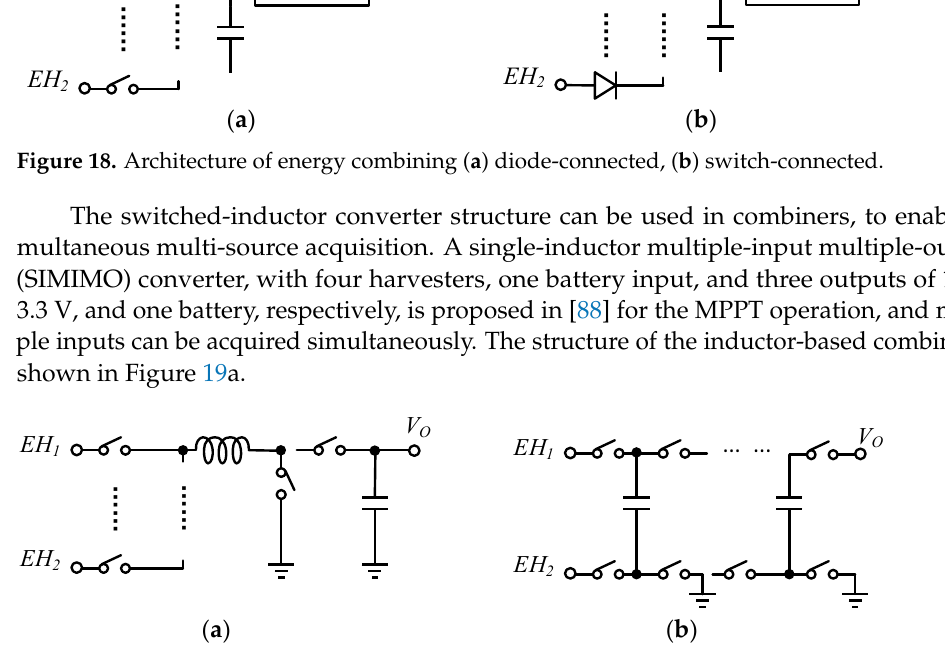
Figure 19. Architecture of energy combining ( a ) inductor-based, ( b ) capacitor-based.